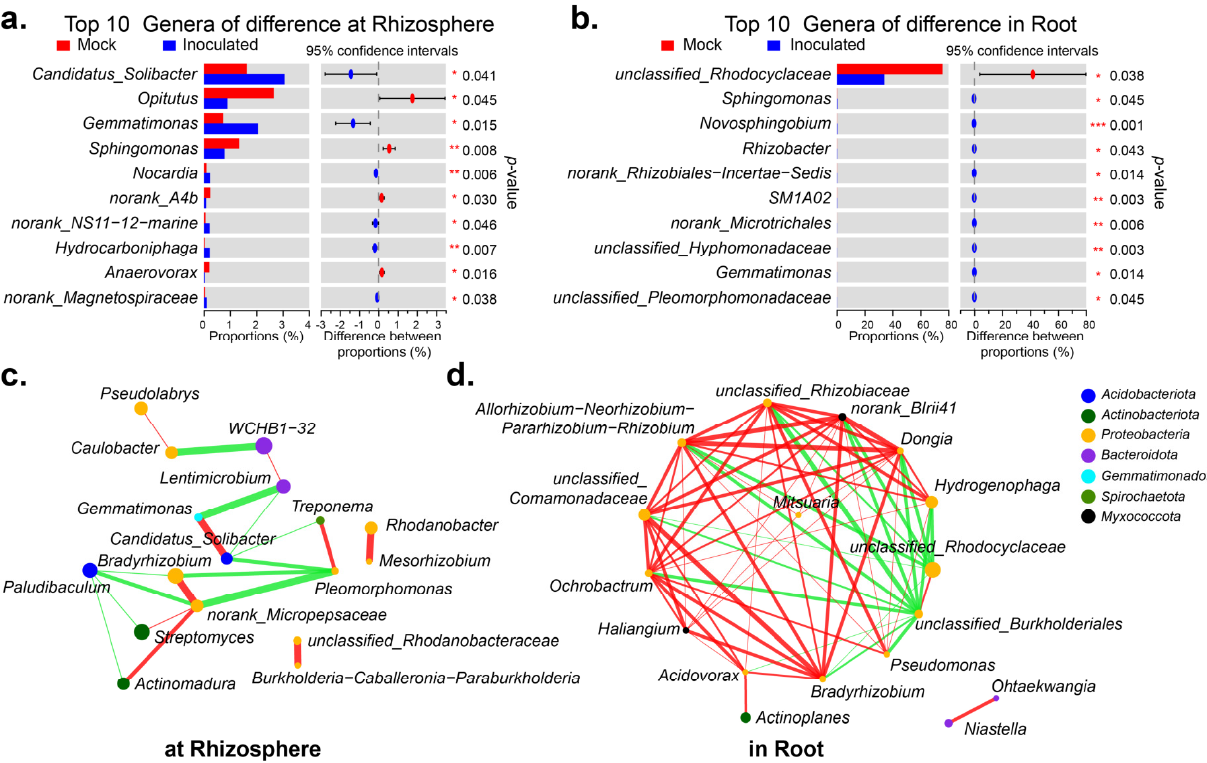
Figure 4. Important genera in rhizosphere and roots. The difference of top 10 genera when inoculated with B. paralicheniformis RP01 and without in rhizosphere ( a ) and in roots ( b ). Sorted by abundance. The species-related network reflected interactions between genera based on abundance, showing top 20 genera-to-genera correlations in rhizosphere ( c ) and in root. ( d ). The size of the nodes indicates the abundance of species, and different colors represent different phyla. The color of the connection line indicates positive and negative correlation, where red indicates positive correlation, and green indicates negative correlation. The thickness of the line indicates the size of the correlation coefficient; the thicker the line, the higher the correlation between species. The more lines, the closer the connection between that species and other species. *, p < 0.05; **, p < 0.01; ***, p <